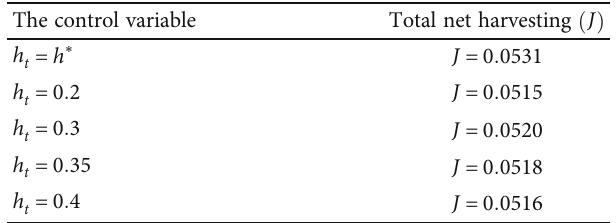
Table 1: This table compares the total optimal harvesting with other total harvesting